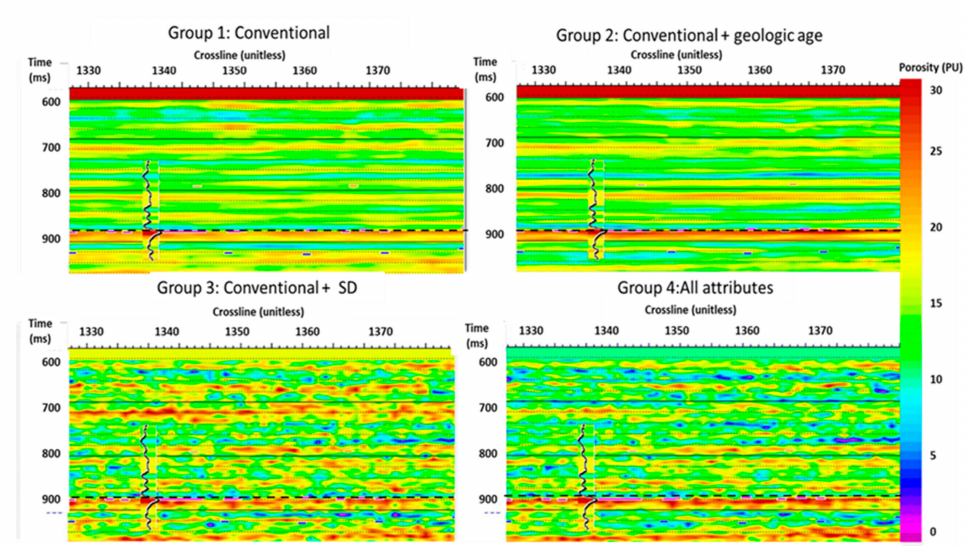
Figure 10. Inline of the predicted porosity volume obtained using each of the attribute groups. The inserted curve is a porosity log filtered to 100 Hz from one validation well and the color background of the curve is the log colored to the same scale as the volume. The dashed black line indicates the top of the main reservoir. Abbreviation: SD, spectral